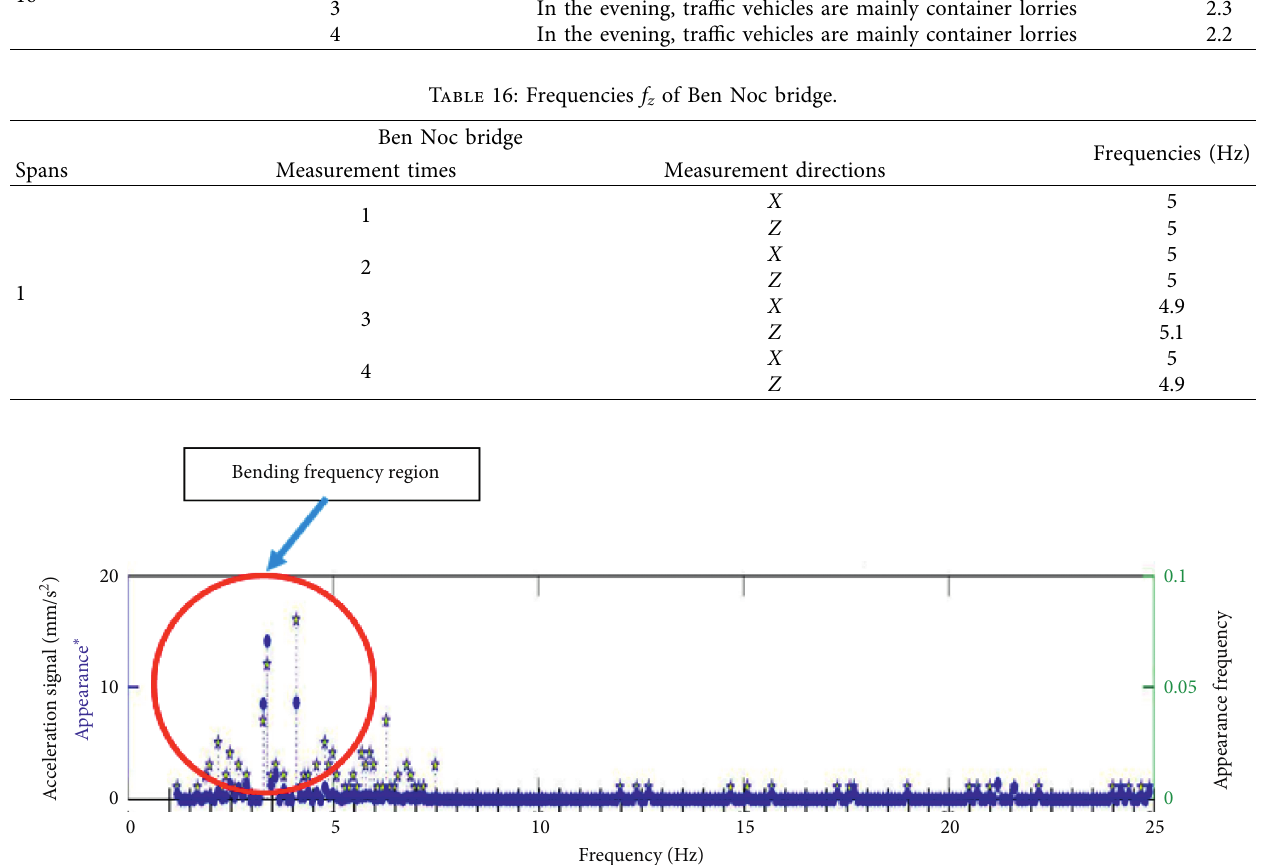
Figure 18: The representative power spectral density of the first span of My Thuy 2 bridge.